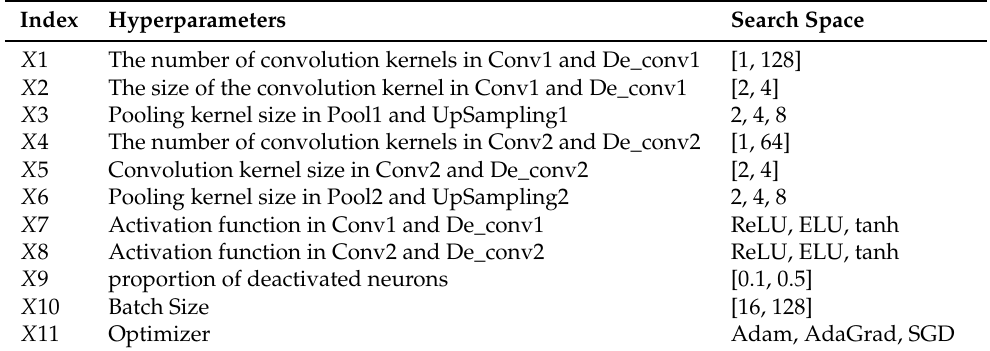
Table 6. The optimization range of some relevant parameters of the